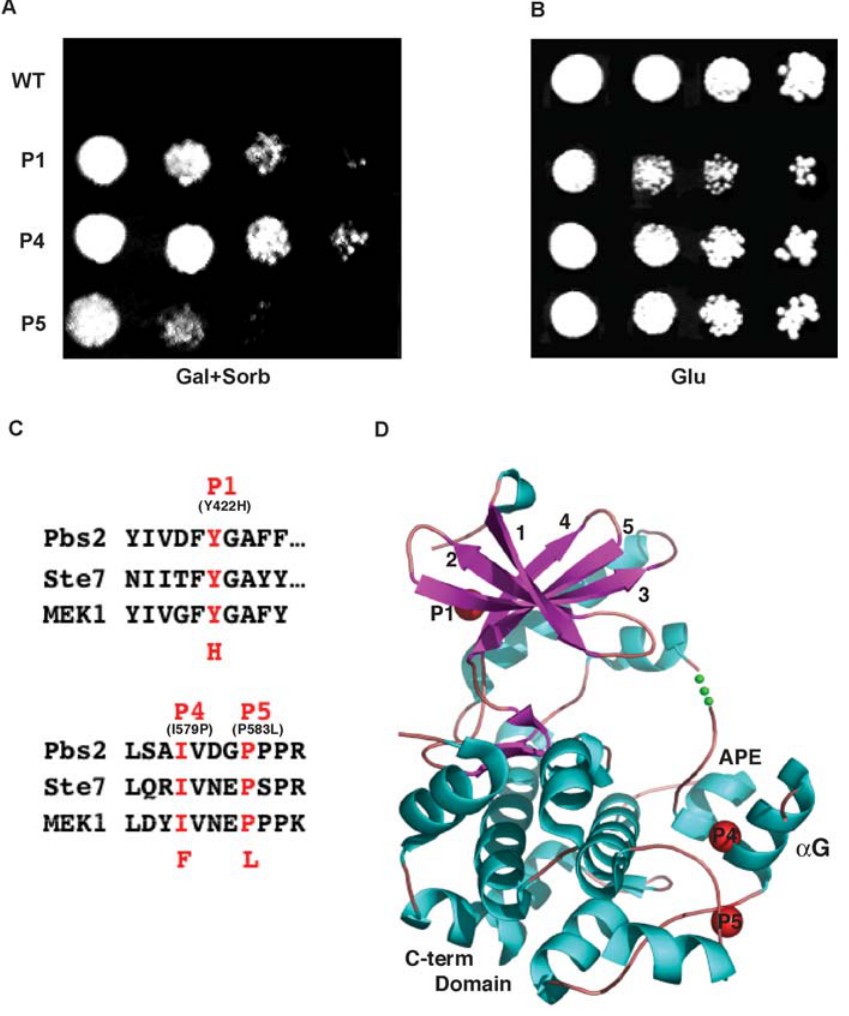
Figure 2. Pbs2 mutants that suppress YopJ inhibition thus survive on sorbitol plate. (A) Dilutions of yeast BY4741- pbs2 D strain co-transformed with YopJ and Pbs2 wild type or mutants are plated on synthetic media containing 2% raffinose, 1% galactose and 1 M sorbitol and incubated at 30 u C. (B) Dilutions of yeast BY4741- pbs2 D strain cotransformed with YopJ and Pbs2 wild type or mutants are plated on synthetic media containing glucose and incubated at 30 u C. (C) Sequence alignment shows all screened mutants are conserved in MKKs from yeast to human. (D) Structural mapping of the screened mutants on a canonical MKK structure: P1 on beta strand 4; P4 on the G a -helix; P5 at the end of the G a -helix.